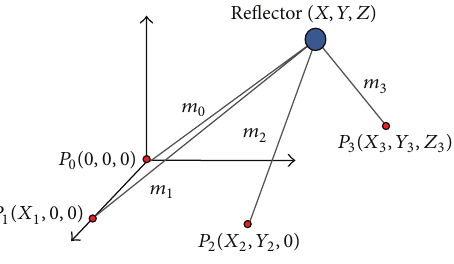
Figure 2: Coordinates of the four laser tracker reference systems expressed in the multilateration